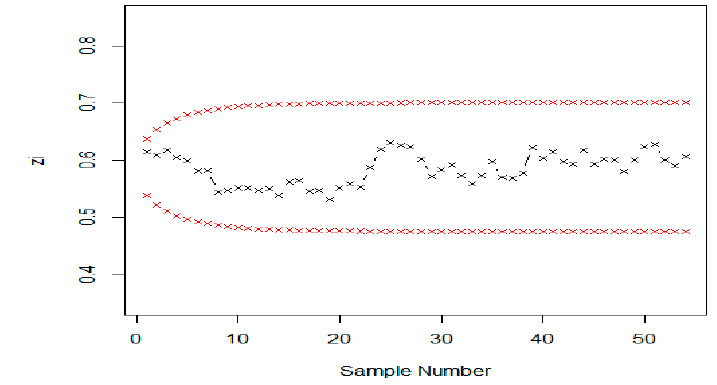
Figure 6. Graph of real data of the EWMA control chart when ψ = 0.30, k = 2.8250, r 0 = 500 .